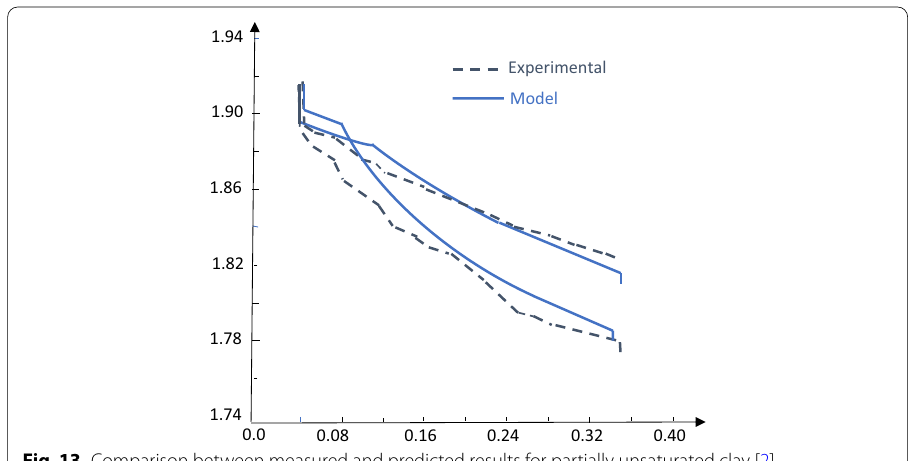
Fig. 13 Comparison between measured and predicted results for partially unsaturated clay